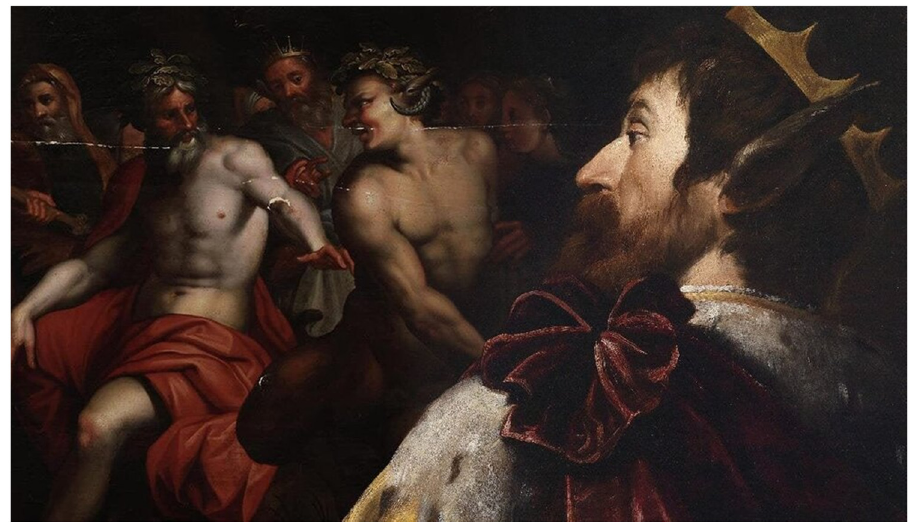
Figure 33: The Judgment of Midas , Unknown Flemish artist, imitator of Hendrik van Balen, late sixteenth century